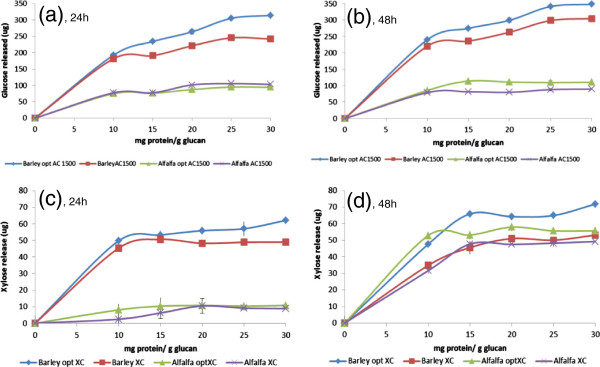
Glucose and xylose released from treated barley straw and alfalfa (biomass load: 0.5%) as function of fungal enzyme loading at 24 h (a, c) and 48 h (b, d) of incubation. Error bars (often invisible) represent SD of the mean (n = 8).